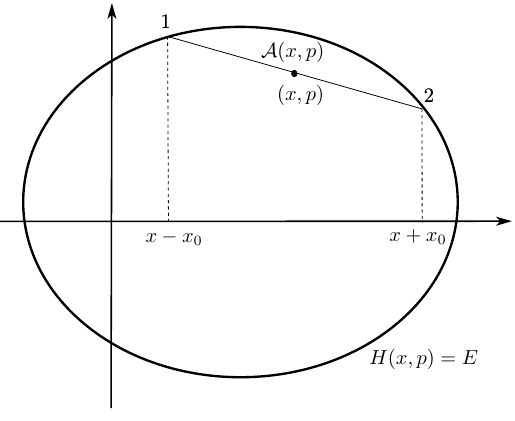
Figure 1 . Berry’s chord construction. The point ( x; p ) is the midpoint of a segment (or chord) whose endpoints lie on the classical curve H ( x; p ) = E . The area of the region between the chord and the curve is denoted by ( x; p ) and we refer to it as the area of the A